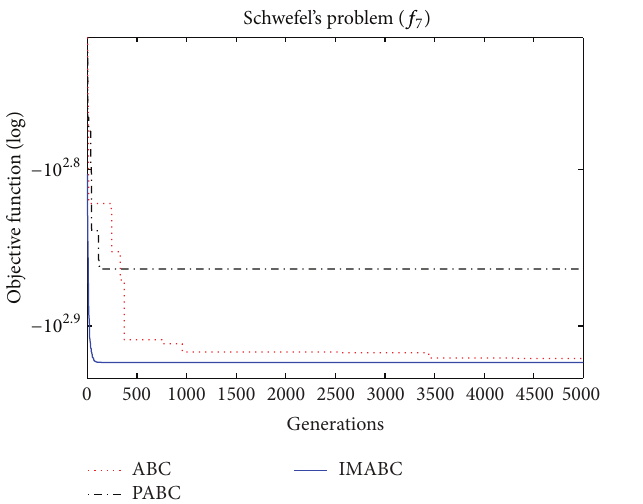
Figure 11: 𝑓 9 function convergence performance comparison.